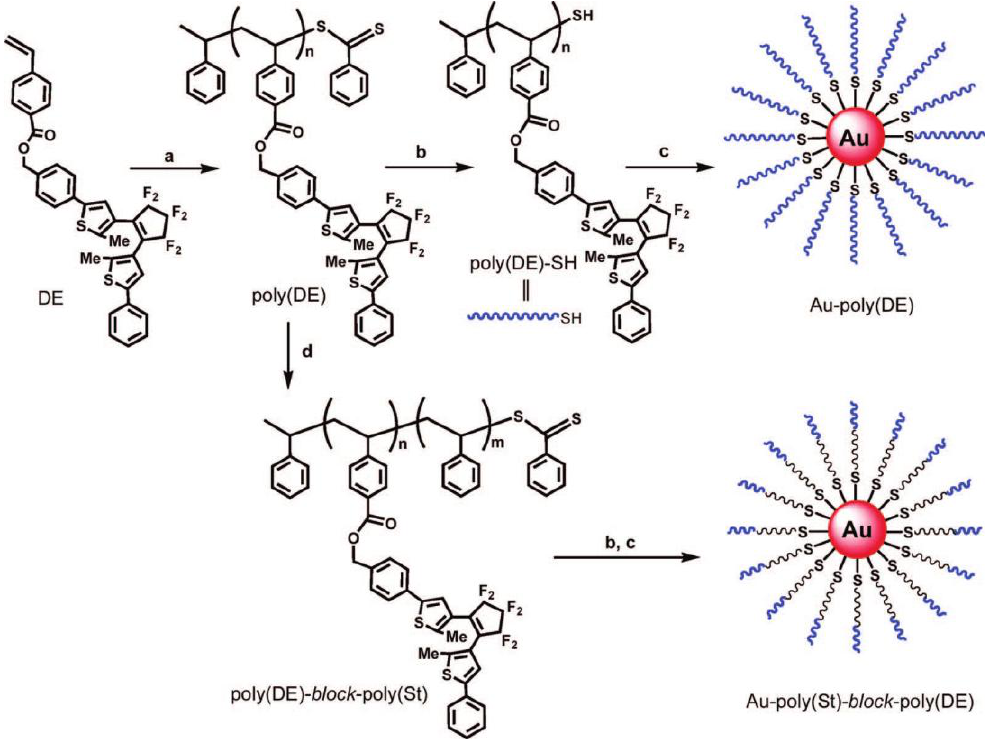
Figure 2. Synthetic scheme for the preparation of Au-poly(diarylethene) and Au-polystyrene- block -poly(diarylethene) hybrid nanoparticles. Reprinted with Permission from Ref. [37]. Copyright 2008 American Chemical Society.